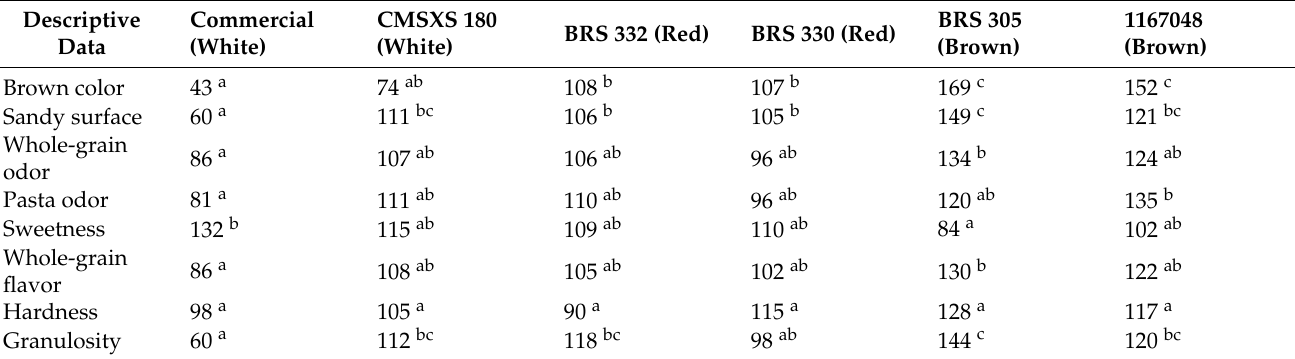
Table 5. Ranking descriptive analysis for the six sorghum